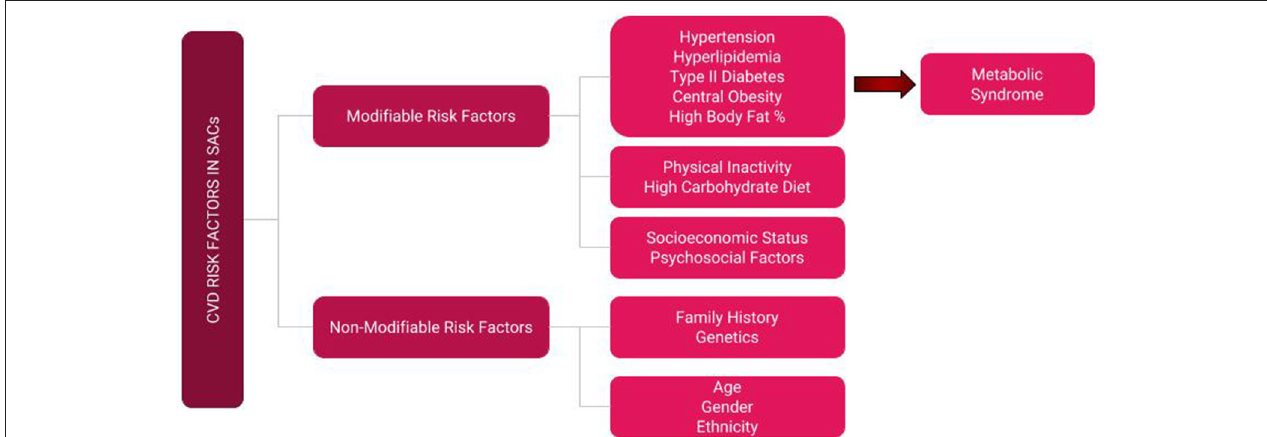
FIGURE 1 | Represents the modifiable and non-modifiable risk factors pertaining to CVD